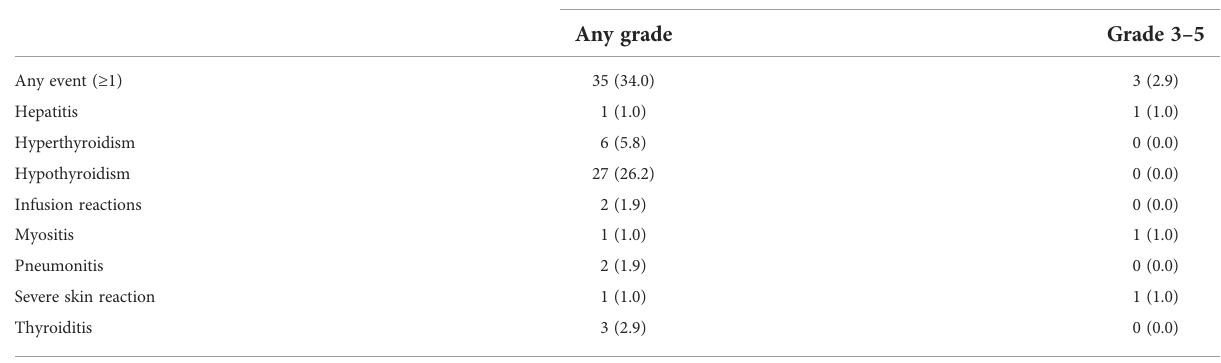
TABLE 2 Immune-related AEs and infusion reactions in ≥ 1 patient (ASaT